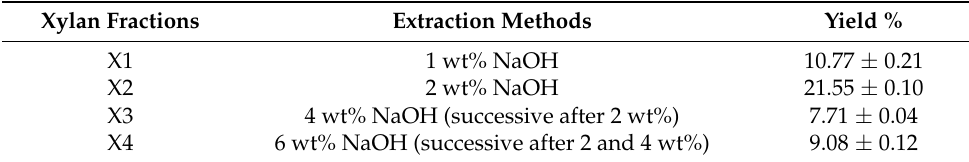
Table 1. Xylans separated through different extraction